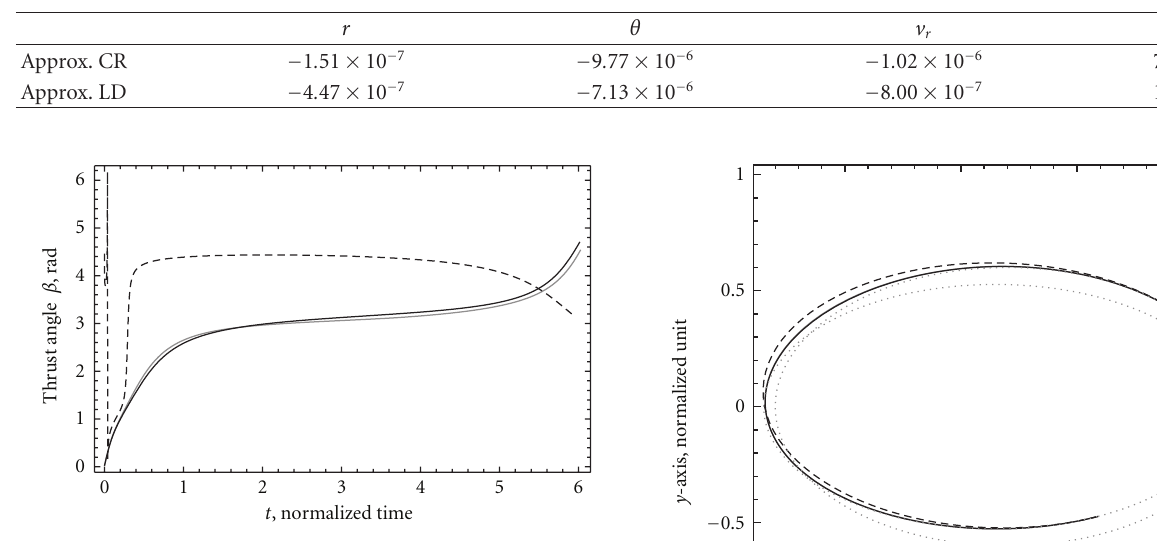
Table 2: Errors induced by the approximate solutions (case D).